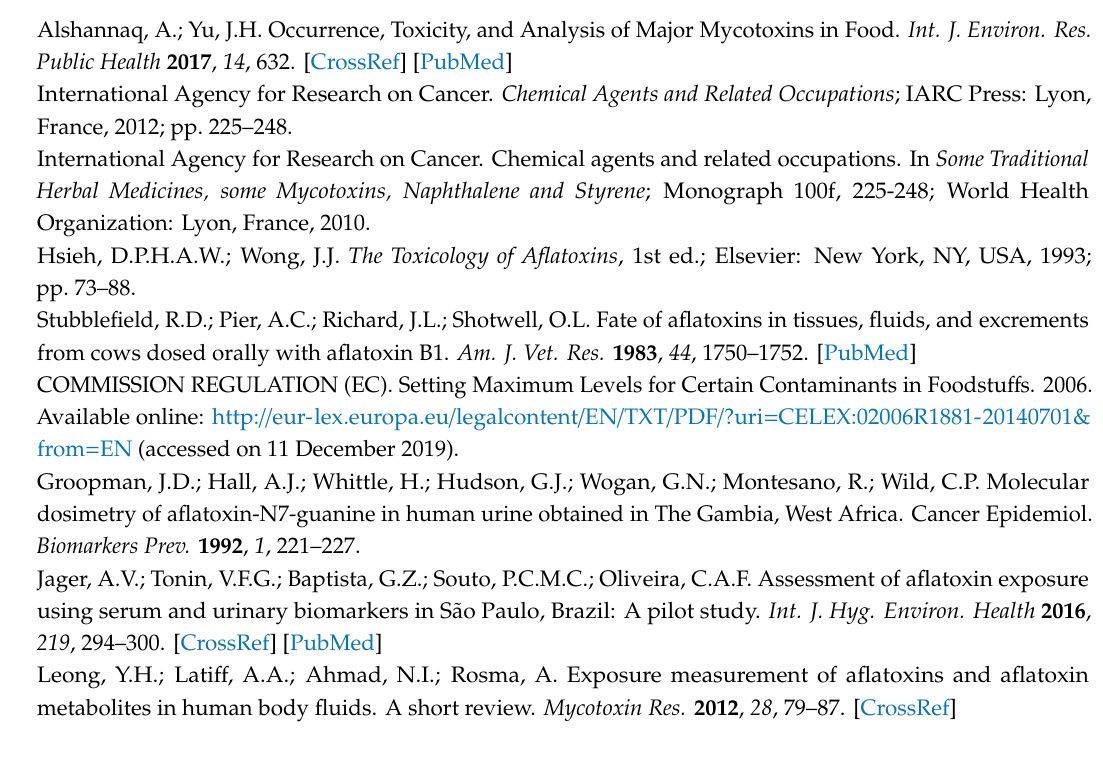
Table S1: Average aflatoxin levels in urine samples of the consumers and non-consumers stratified by occupational